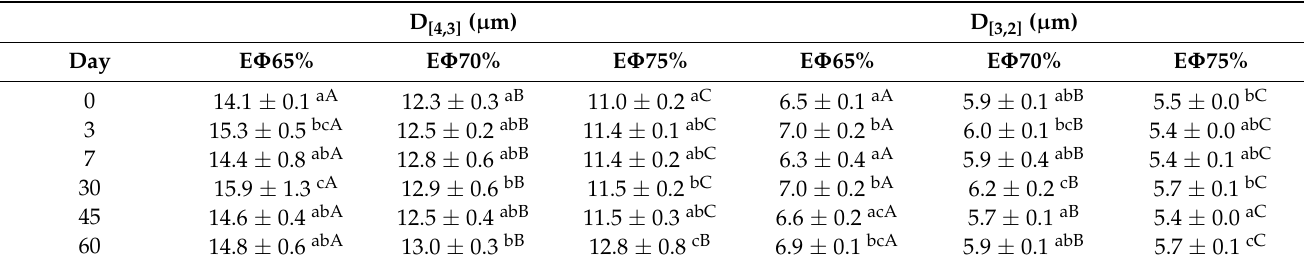
Table 1. Droplet mean diameter (D [4,3] and D [3,2] ) of the emulsions and HIPE during 60 days of storage at 25 °C.